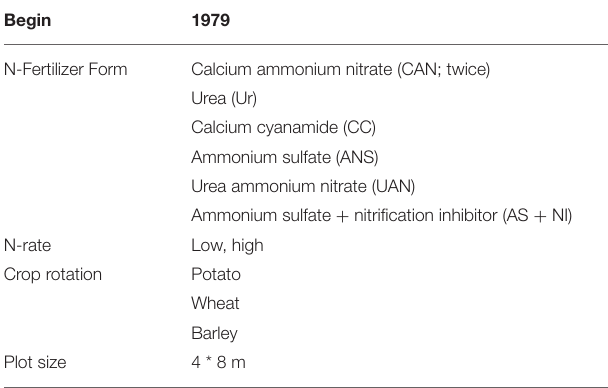
TABLE 1 | Site description of the long term fertilization experiment in Dürnast (Heil and Schmidhalter, 2017).